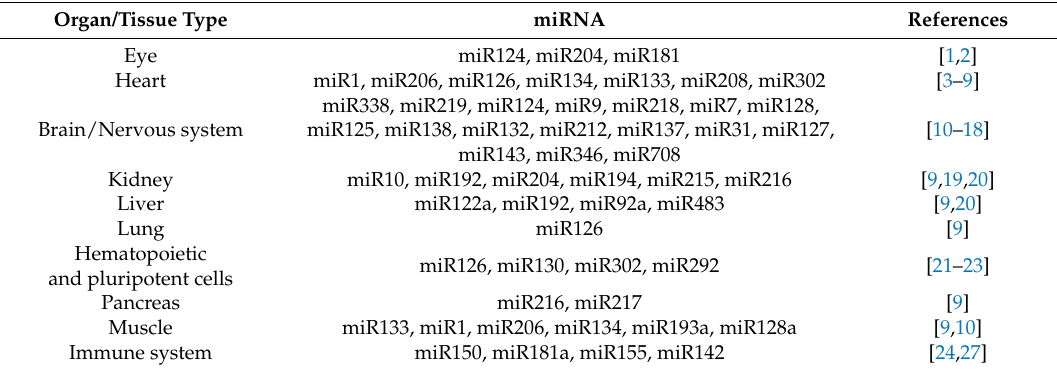
Table 1. miRNAs specific to or enriched in